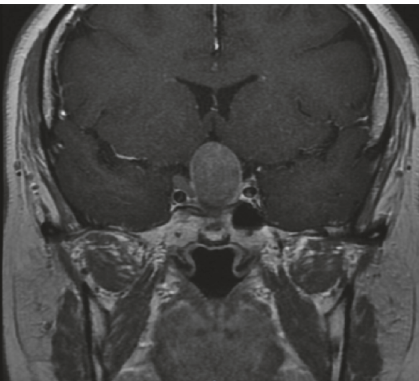
Figure 1: Coronal MRI T1 sequence with gadolinium. Intra- and suprasellar tumor with extension to the floor of third ventricle, after first surgery.